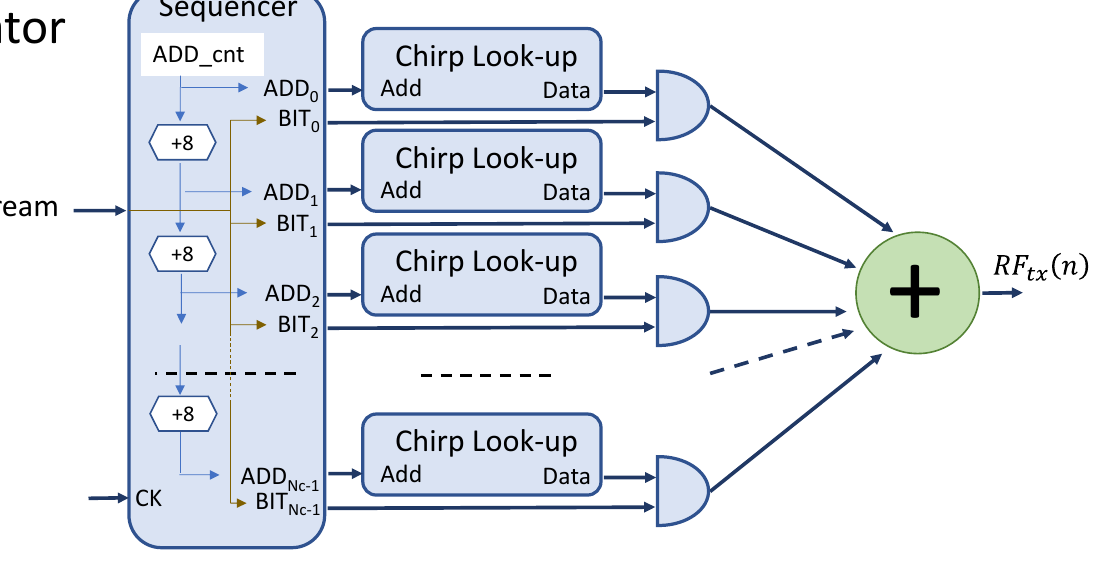
Figure 6. Architecture of the modulator.